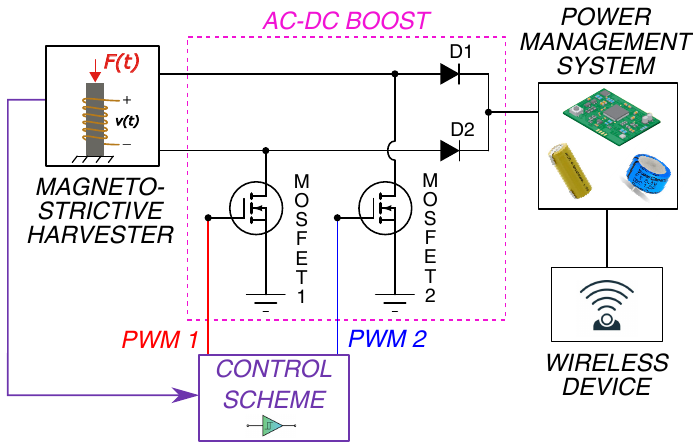
Figure 2. Block scheme of a VEH based on a magnetostrictive material with an AC–DC boost